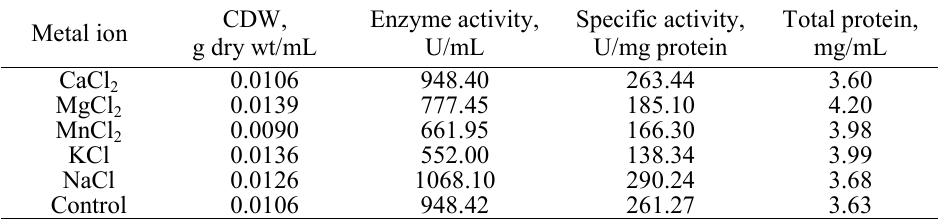
Figure 7. Effect of surfactants on the production of alkaline protease produced by Str. pseudogrisiolus NRC-15 on 200 rpm at 96 h. Table 3. Effect of metal ions on the production of alkaline protease produced by Str. pseudogrisiolus